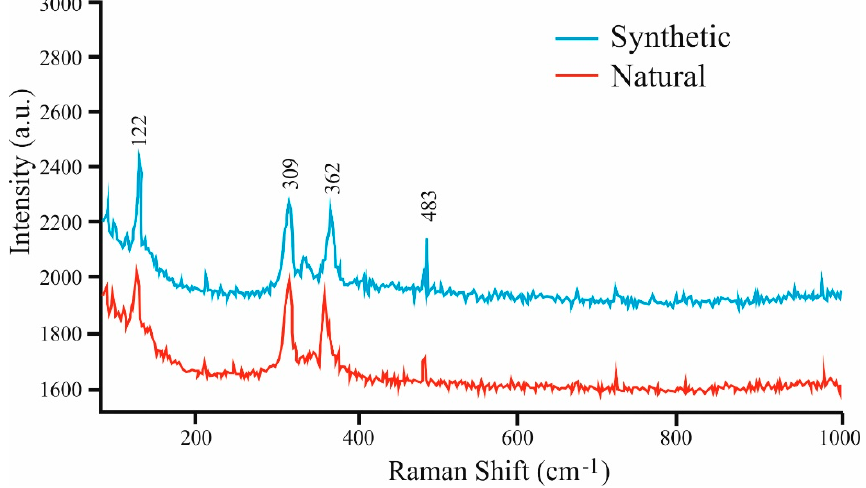
Figure 8. Comparison of Raman spectra in the synthetic Pd 9 Ag 2 Bi 2 S 4 and in the natural